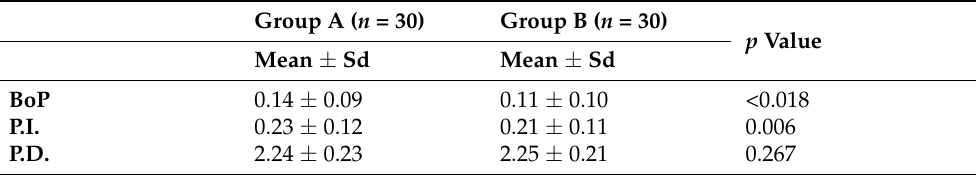
Table 3. Periodontal and microbial parameters among the A group and B group before suppression of oral irrigator in group B. (T 0 ) .